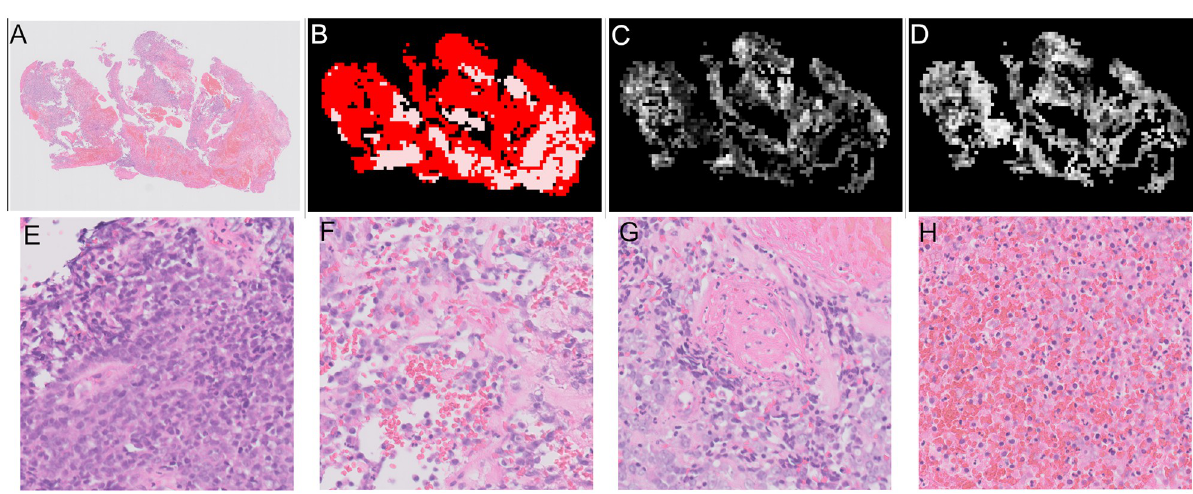
Fig 19. Example of a slide where patch classification is unsure. (A) Thumbnail showing slide where patch classification is unsure, “malignant” slide. (B) Mask showing areas of “malignant” tissue in red and “blood or mucus” in pink. (C) Results of patch classification showing probability of “malignant”, white = 1, black = 0. (D) Results of patch classification showing probability of “other or benign”, white = 1, black = 0. (E) Example “malignant” patch probability “malignant” = 0.980 (F) Example “malignant” patch probability “malignant” = 0.502 (G) Example “other or benign” patch probability “malignant” = 0.498 (H) Example “other or benign” patch probability “malignant” = 0.008.